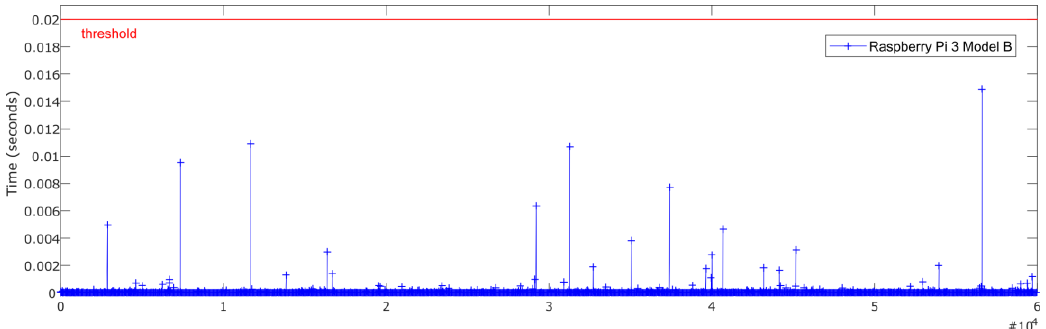
Table 8. Test 3. Processing time on Raspberry Pi 3 Model B and Intel Edison.